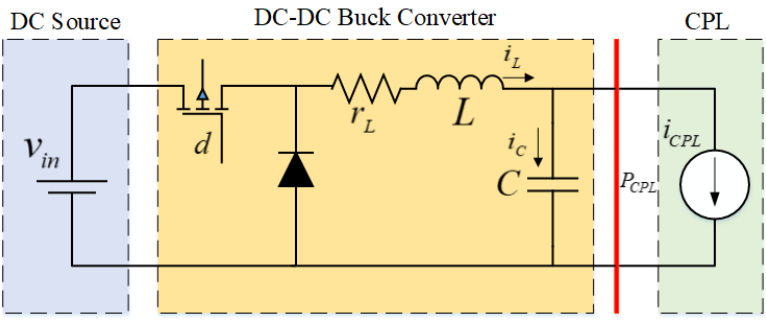
Figure 3. Equivalent circuit model of a buck converter supplying a CPL.